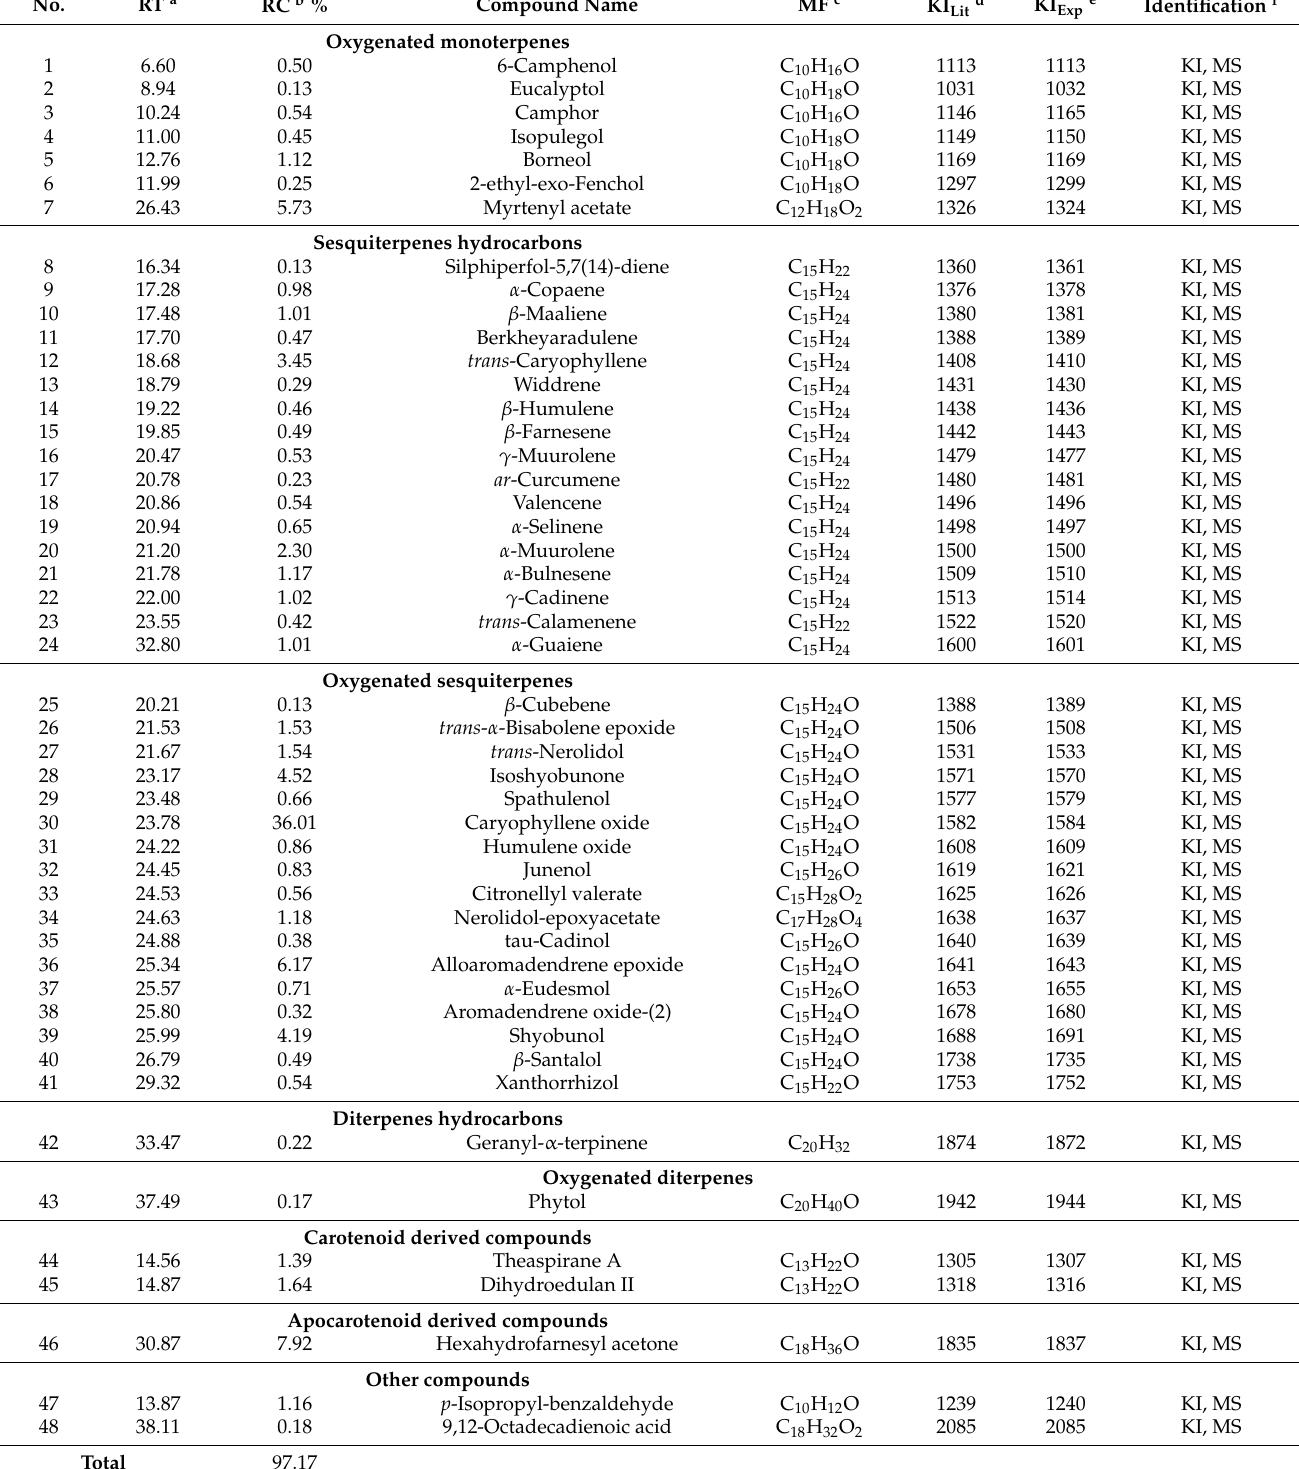
Table 1. Chemical components of the essential oil of above-ground parts of Cleome amblyocarpa